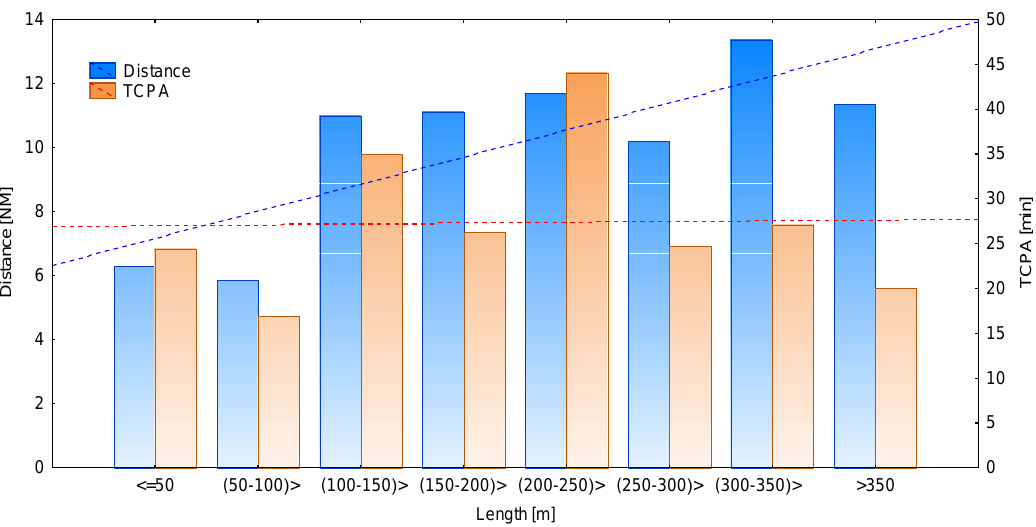
Figure 4. Relation between length of the target ship, TCPA and the distance between ships at the start of the